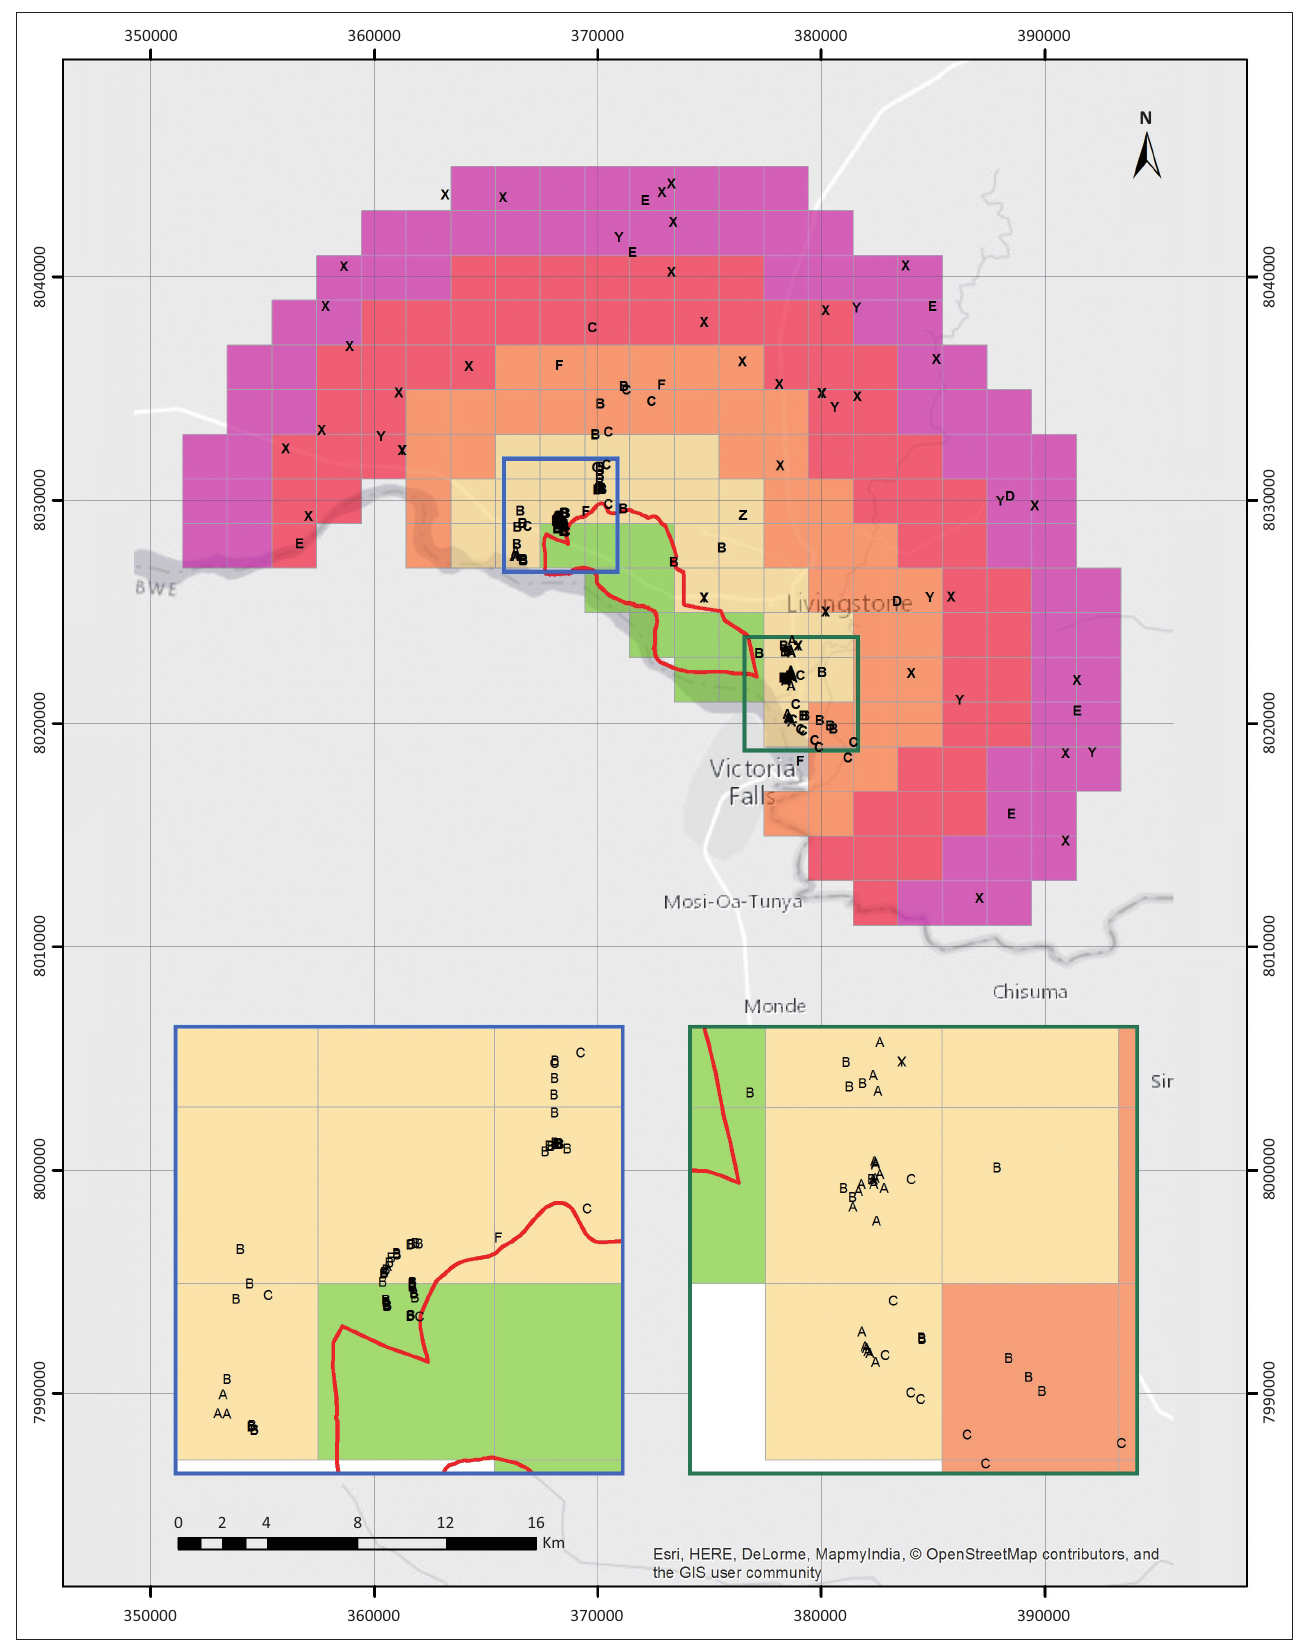
FIGURE 2: Map of the Livingstone area with indications of elephant presence or